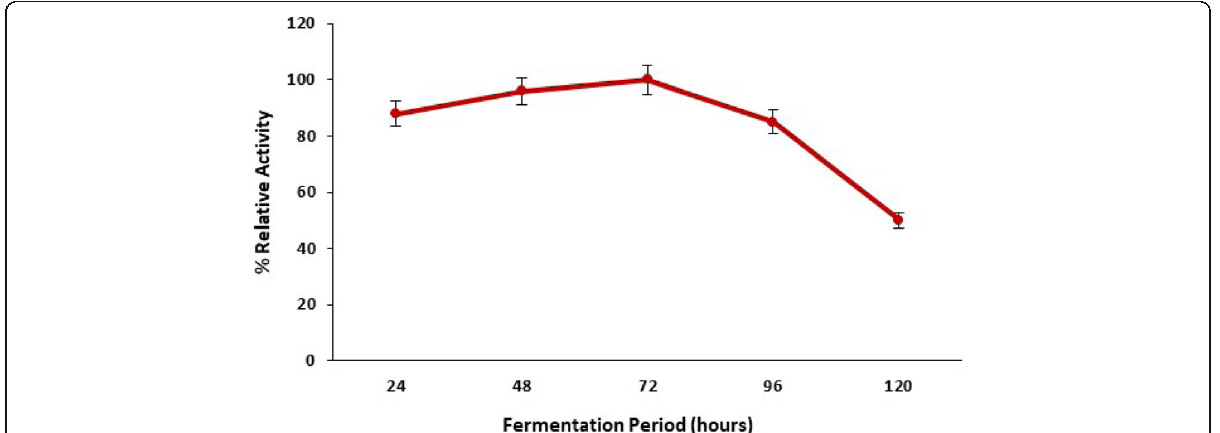
Fig. 3 The influence of fermentation period on pectinase production by B. licheniformis KIBGE-IB3 using date fruit wastes as substrate (means ± S.E., n =